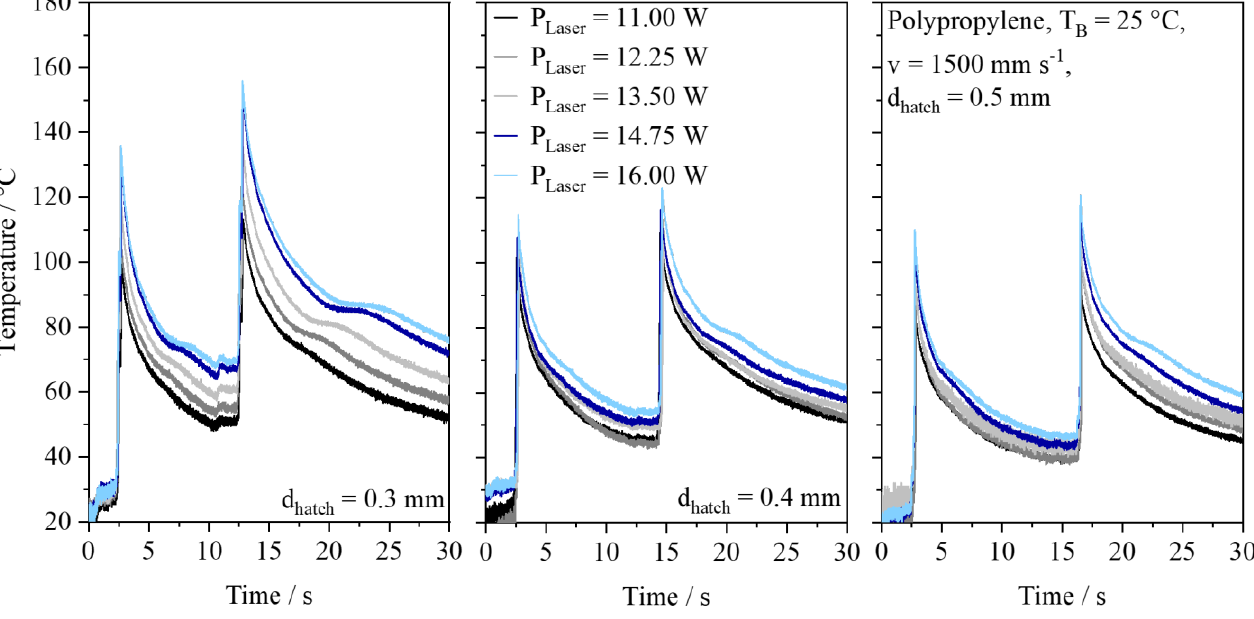
Figure 4. Influence of hatch distance and laser power on emerging time–temperature profiles, v Exposure = 1500 mm s −1 .